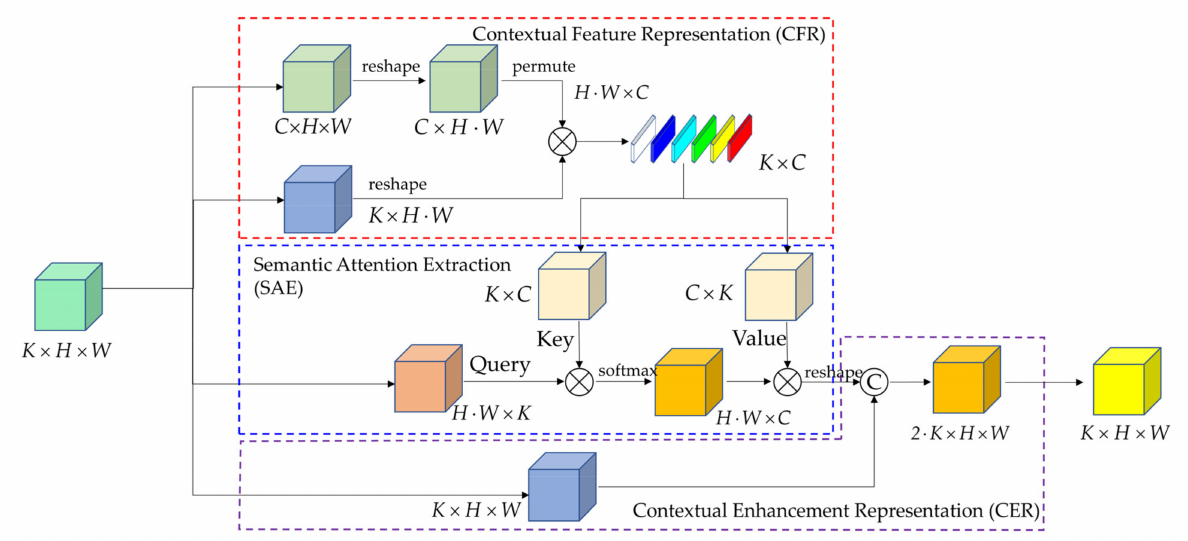
Figure 3. The elaborate structure of the context-enhanced